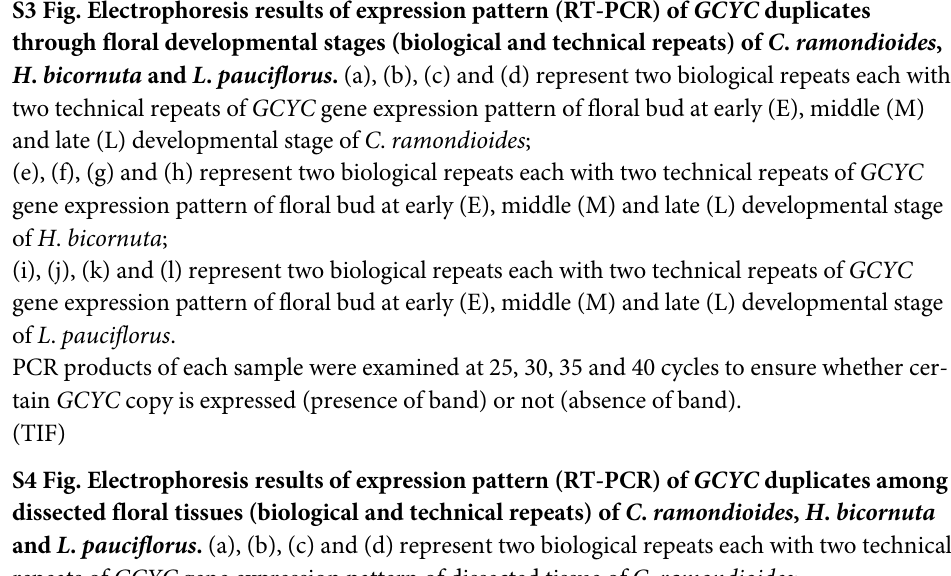
S3 Fig. Electrophoresis results of expression pattern (RT-PCR) of GCYC duplicates through floral developmental stages (biological and technical repeats) of C . ramondioides ,